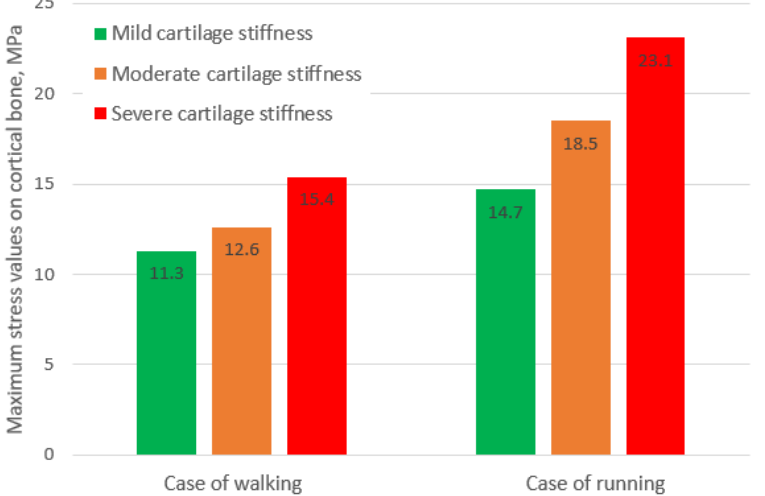
Figure 14. Maximum von Mises stress values on cortical bone in case of various cartilage sti ff ness and loading conditions.